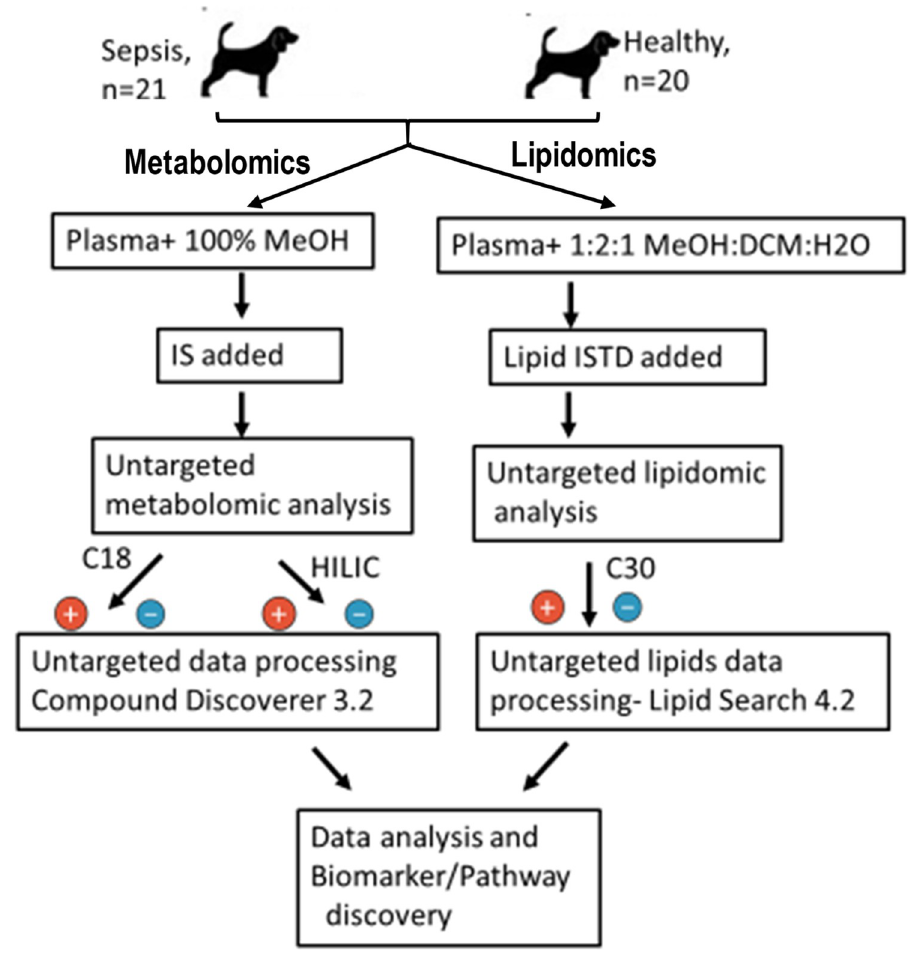
Fig 1. Schematic diagram for untargeted metabolomics and lipidomics workflow for analysis of plasma samples collected from dogs with sepsis and from healthy controls. Small-molecule metabolites and lipids were extracted from the sample matrix. Metabolites and lipids were separated using chromatographic steps, ionized, and analyzed using mass spectrometry (MS). Features of interest were selected from the raw data using univariate and multivariate statistical approaches and then identified using database searches, comparisons to authentic standards, and MS/MS. Identified features were then used for pathway analysis, and to distinguish potential metabolite biomarkers.